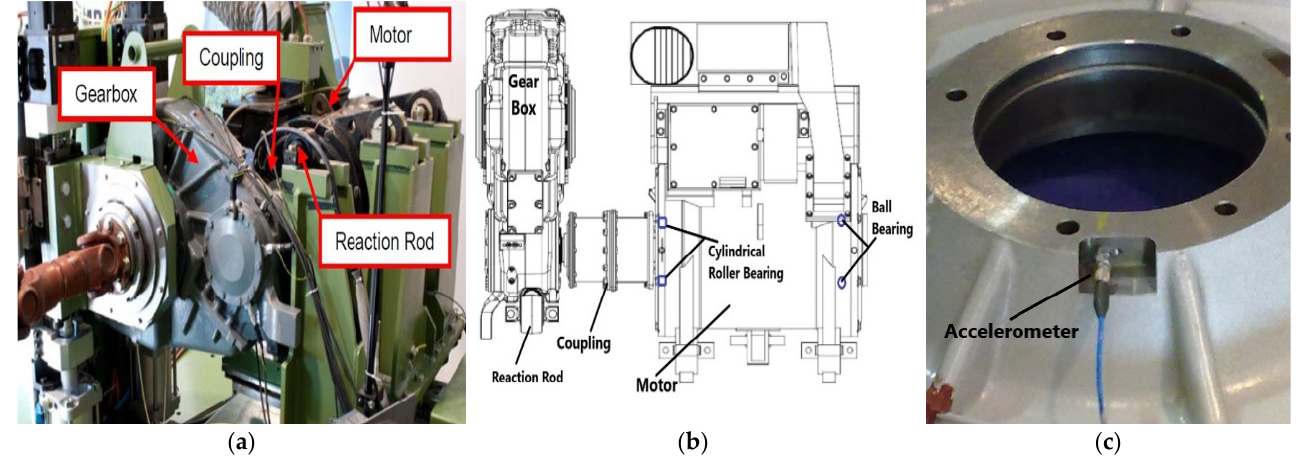
Figure 9. Test rig-2 layout. ( a ) main components ; ( b ) under study bearings’ position ; ( c ) accelerome- ter’s position.